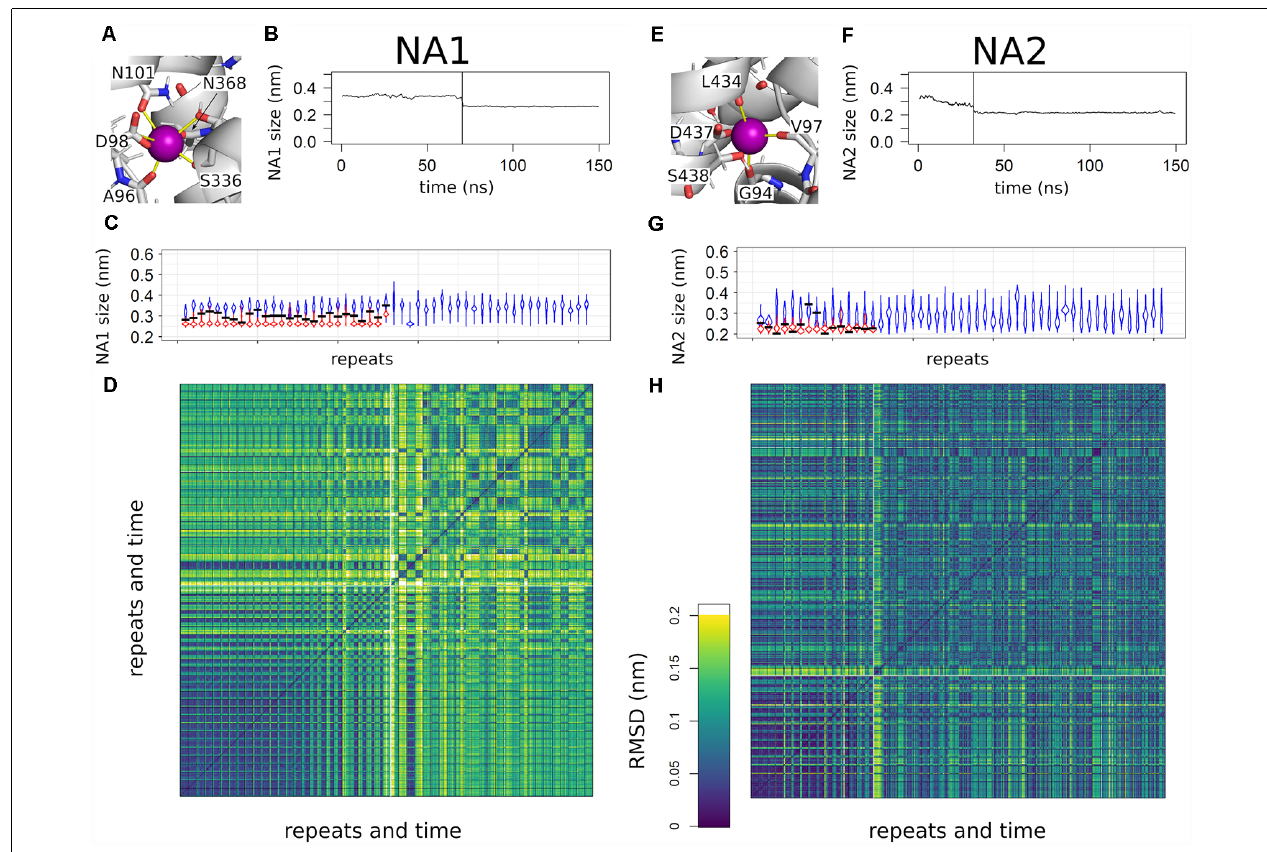
FIGURE 4 | Overview of sodium binding to NA1 and NA2. (A,E) Close up to NA1 and NA2. Distances used for the compactness measurement are highlighted by yellow lines. The same binding atoms are also used for the root mean square deviation (RMSD) analyses. (B,F) A representative example for the change in the compactness upon sodium binding. The time point of sodium entering NA1 or NA2 is highlighted by a vertical line. Curves are smoothed by a 1 ns running average. (C,G) Violin plots of the binding site compactness for all simulations sorted according to the time point of sodium binding to NA1 or NA2, respectively. In case of a sodium binding event, the trajectory was divided at the time of sodium binding. The violin in blue represents the pre-bound state and the violin in red shows the compactness after binding. The compactness at the time point of sodium binding is highlighted by a horizontal black line. The temporal resolution of the distance analysis was 100 ps. (D,H) RMSD analysis of all simulations sorted as in panels (C,G) of the atoms used for measuring NA1 and NA2 compactness. The boundaries between individual simulations are indicated by a black grid, while the white lines are used to separate simulations that show sodium binding from simulations in which sodium does not bind to SERT. Temporal resolution for the RMSD matrix was 10